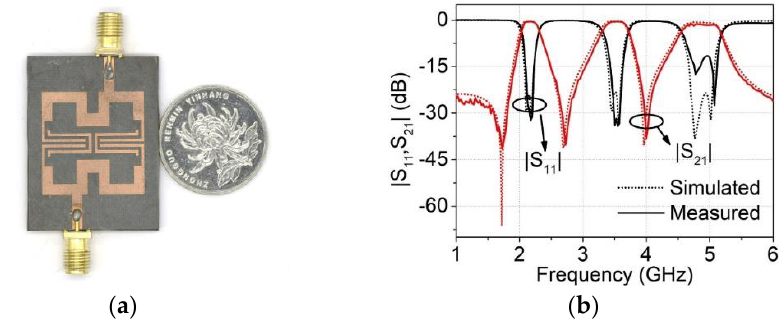
Figure 8. Manufacture and measurement of the dual-wideband BPF. ( a ) The photograph of a dual-wideband BPF; ( b ) The simulated and measured |S 21 , S 11 | response of the dual-wideband BPF.